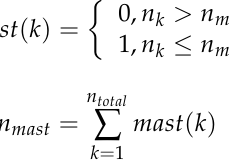
Figure 10. Statistical curves of the bright spots in the segmented regions: ( a ) A scene before the object